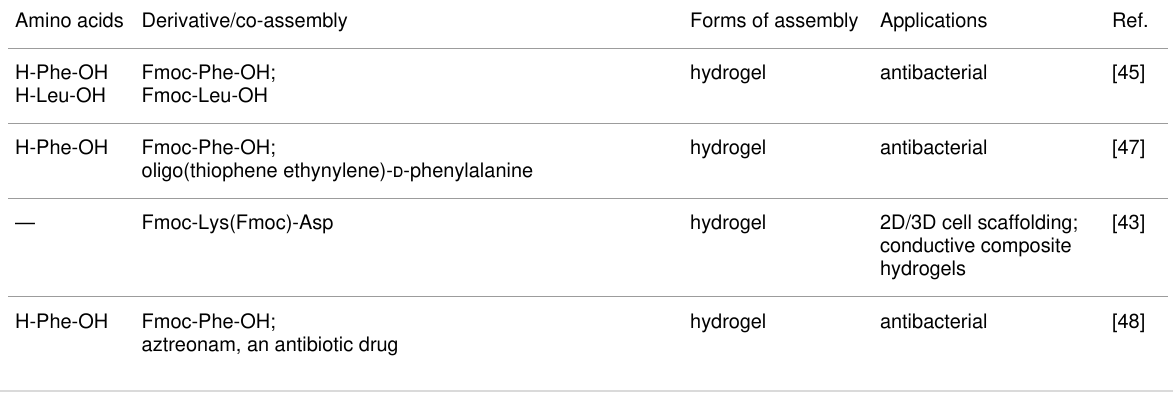
Table 1: Summary of amino acids/amino acid derivatives and their applications. Amino acids Derivative/co-assembly Forms of assembly Applications